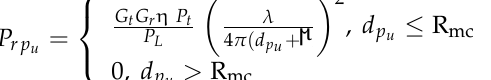
Figure 1. Network model and components .